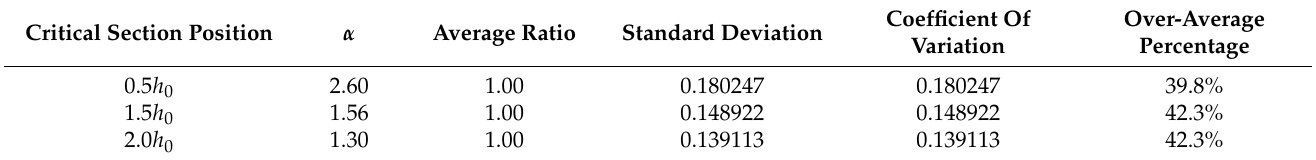
Table 5. Specimens parameters.